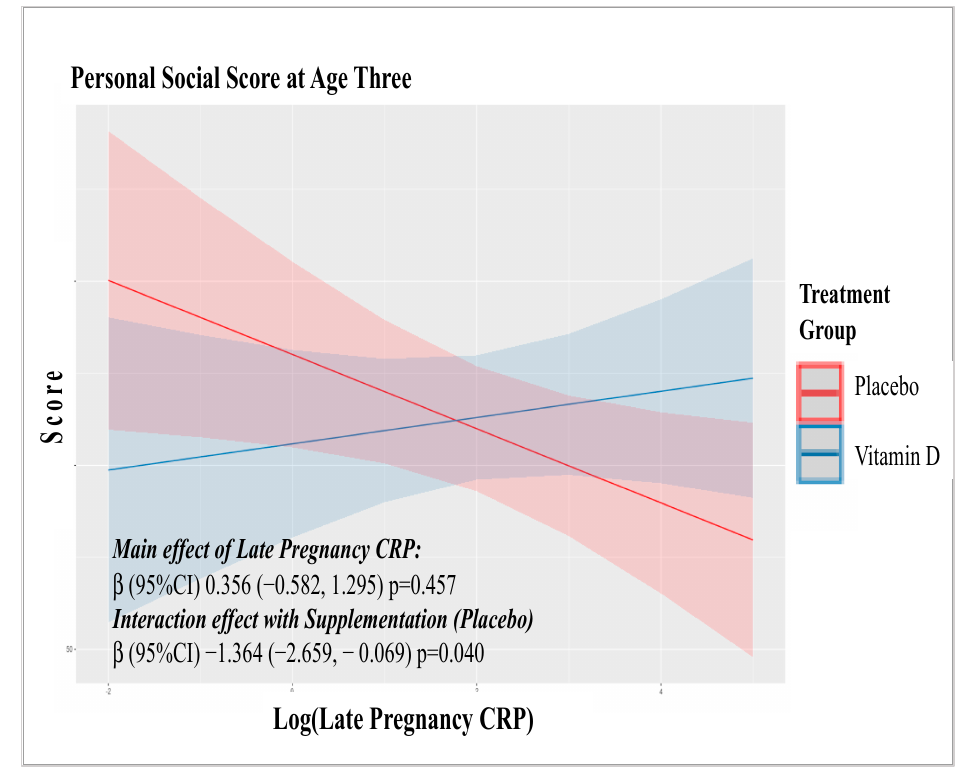
Figure 4. Interaction between log transformed IL8 levels in the first and third trimester and vitamin D supplementation with Personal-Social skills score at Age Three.